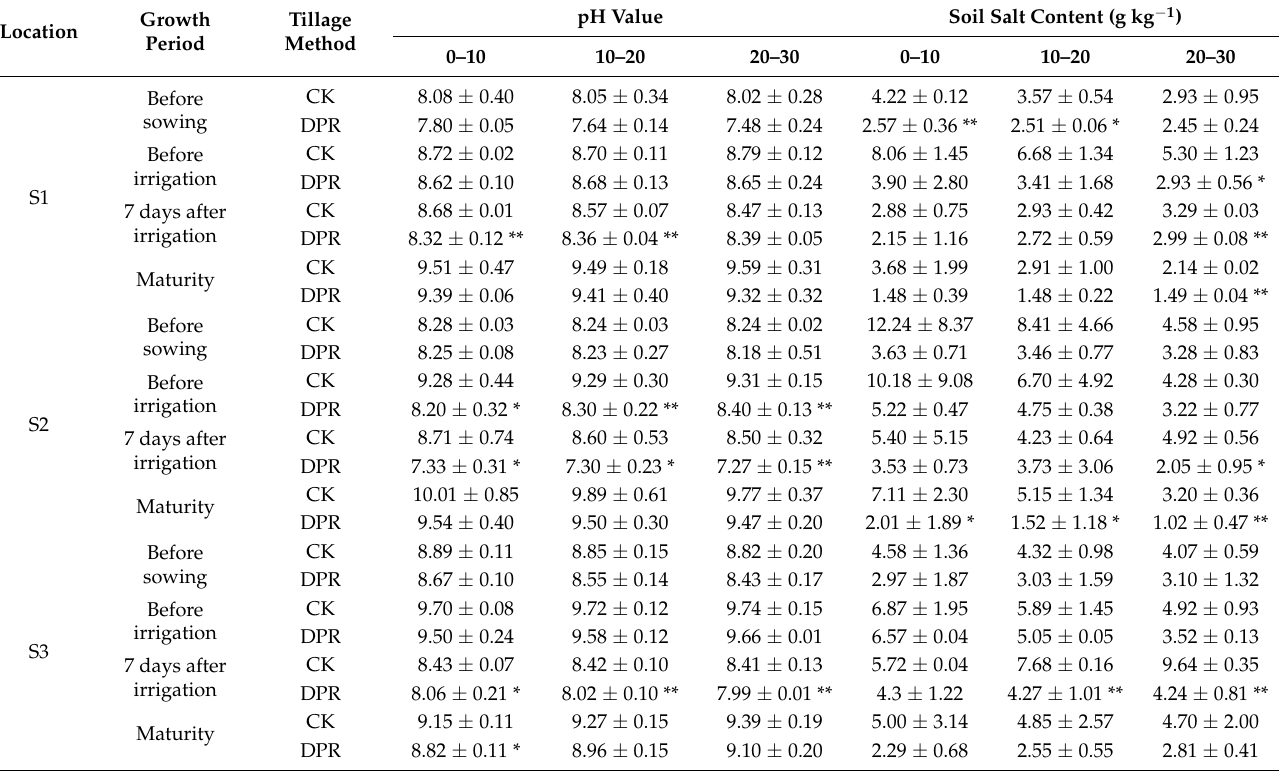
Table 4. Effects of deep straw return on soil pH value of saline